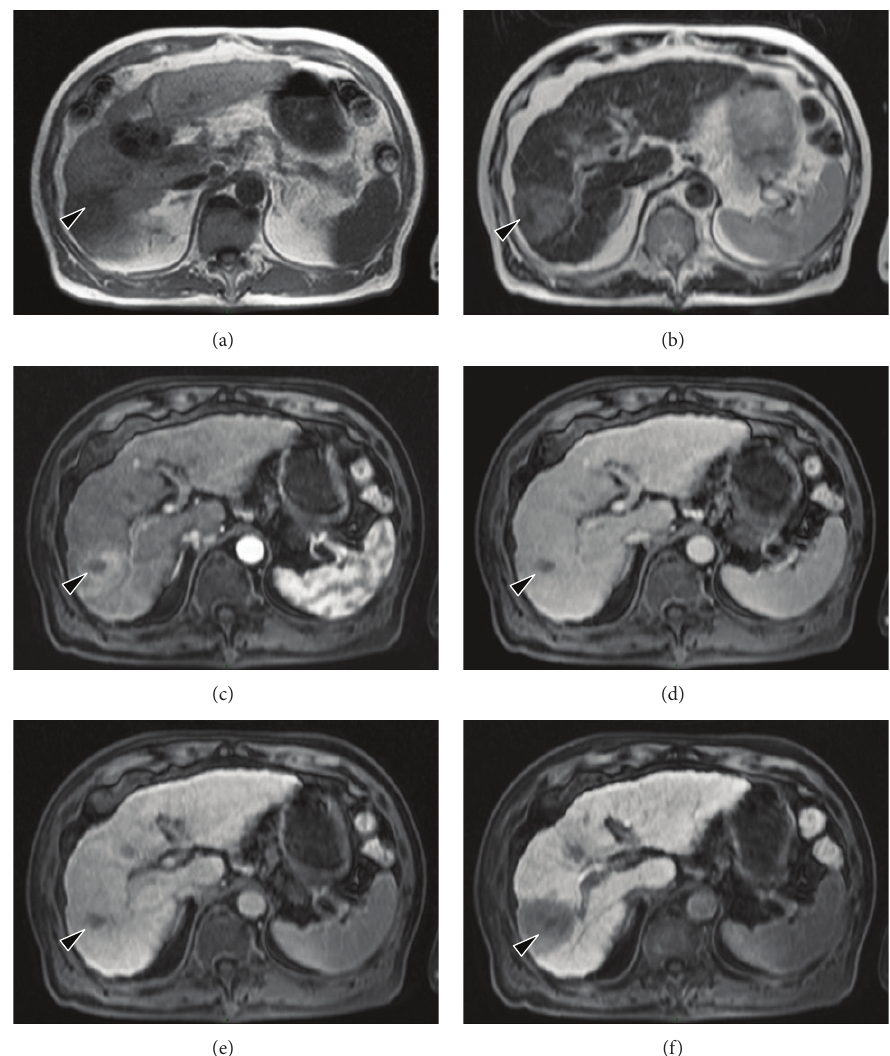
Figure 3: MR images obtained approximately two months after transcatheter arterial chemoembolization and radiofrequency ablation. (a) A hypodense area measuring approximately 3cm in diameter is observed on T1-weighted image. (b) A hyperintense area is found on T2- weighted image. ((c)–(f)) Gadolinium ethoxybenzyl diethylenetriamine pentaacetic acid-enhanced images. In the arterial phase following contrast injection (c), the center of the tumor is enhanced intensely and homogeneously. In the delayed phase (d) and hepatobiliary phase (f), the tumor is completely washed out. e: portal phase.